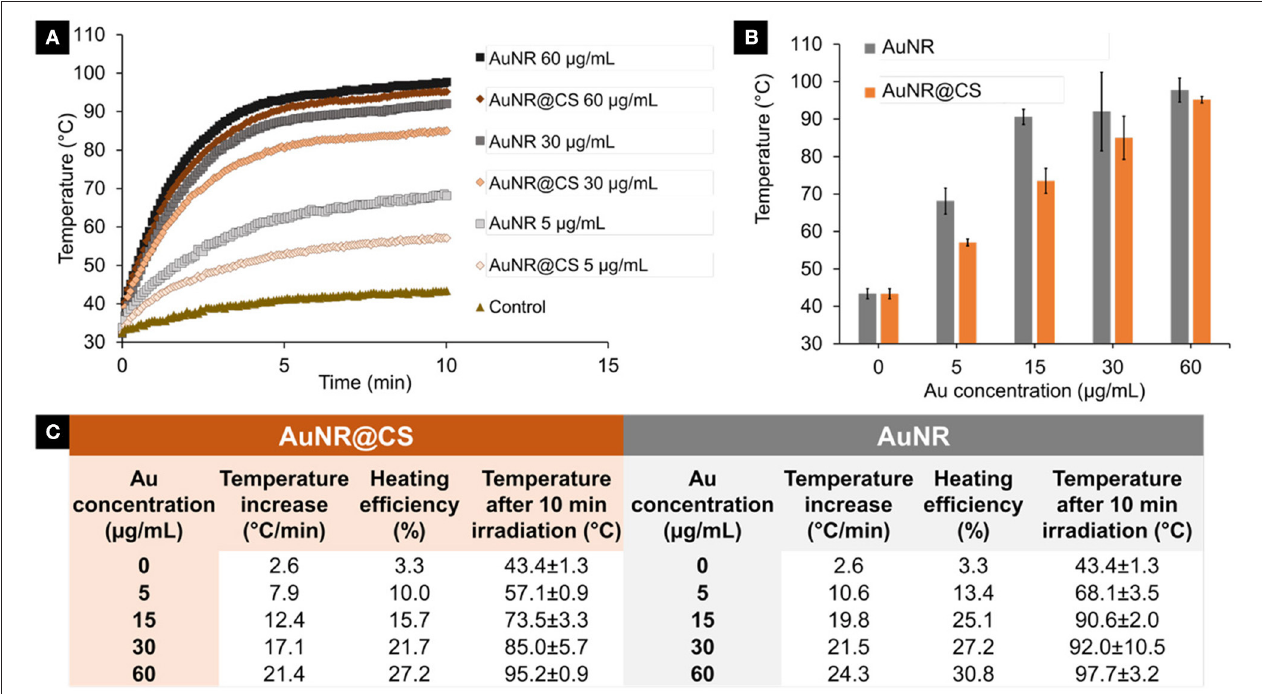
FIGURE 3 | (A) Temperature increase during 10min irradiation of different concentrations (5–60 µ g/ml) of AuNR and AuNR@CS. (B) Final temperature after 10min irradiation of different concentrations of AuNR and AuNR@CS. (C) General data table of all tested samples, including concentrations, initial temperature increase, heating efficiency, and final temperature after 10min irradiation.